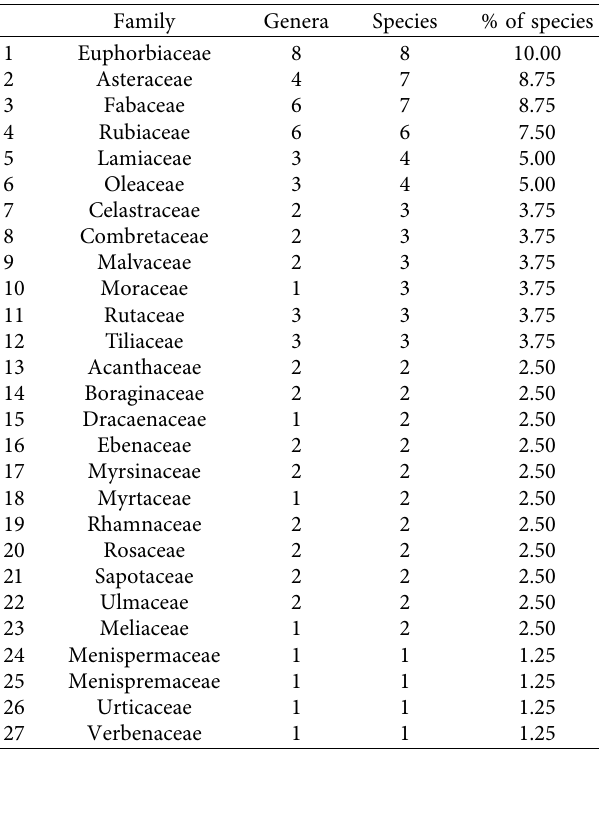
Table 1: List of families with number of genera and species.